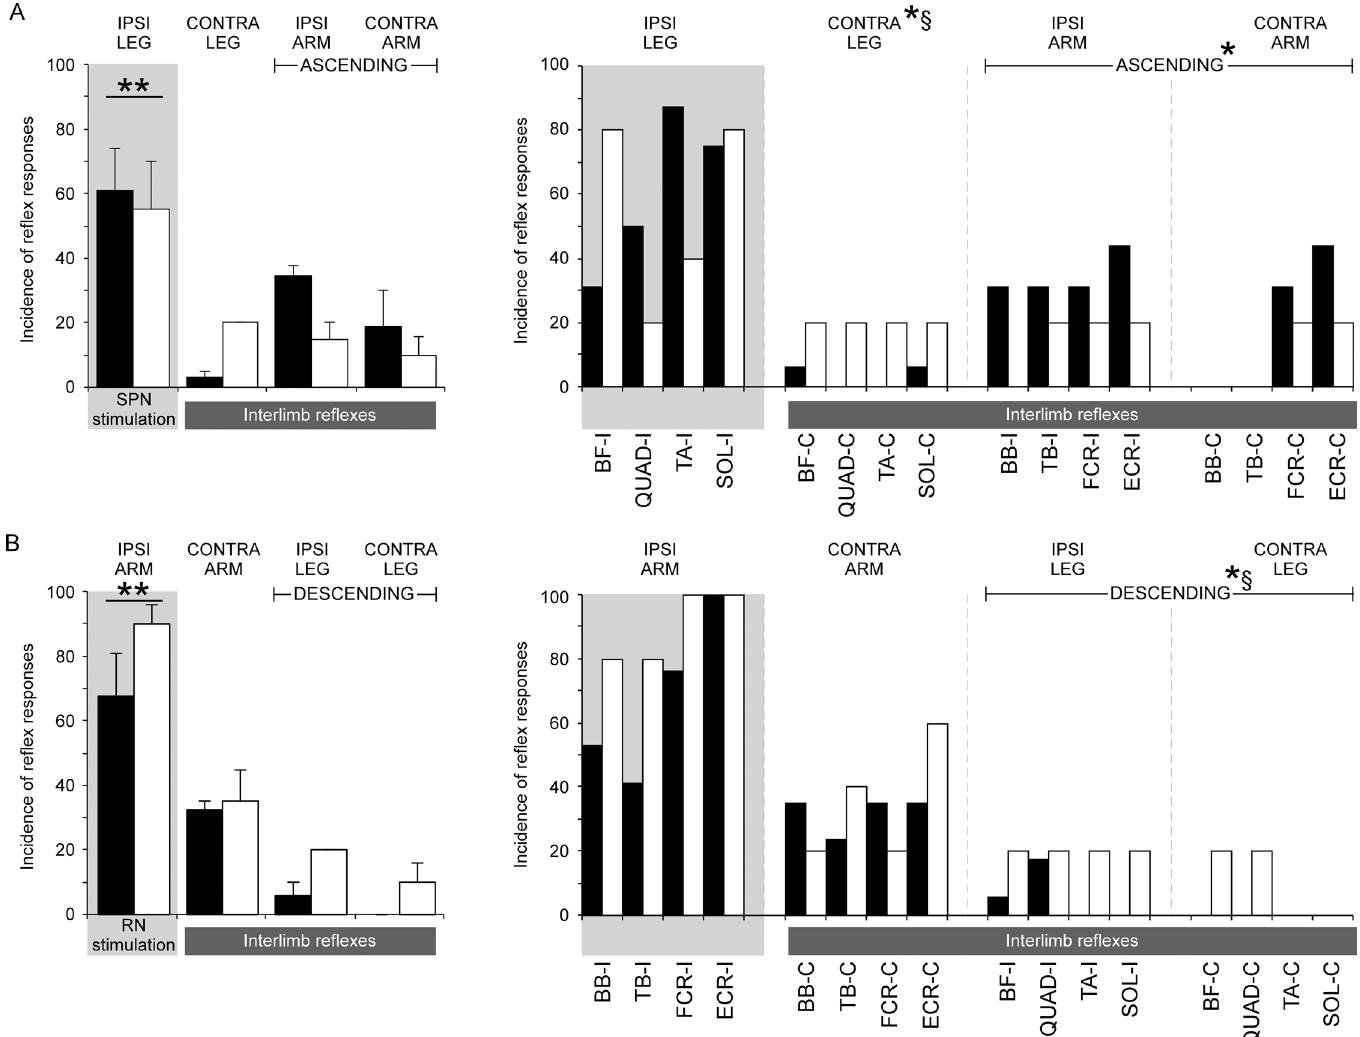
Fig 4. Incidence of within-limb, interlimb, and muscle reflexes. Incidence of limbs (left) and muscles (right) in which reflexes were evoked in participants with spinal cord injury (SCI) (filled bars; n = 17) and able-bodied (AB) control participants (open bars; n = 5) by SPN stimulation (A) and RN stimulation (B). Within-limb reflex data are shaded. Muscles from the arm are indicated by BB – biceps brachii, TB – triceps brachii, FCR – flexor carpi radialis, and ECR – extensor carpi radialis, and muscles from the leg are indicated by BF – biceps femoris, QUAD – quadriceps, TA – tibialis anterior, and SOL – soleus. ** indicates significant differences in incidence between within-limb and interlimb reflexes § indicates significant differences in incidence between SCI and AB control groups. * indicates a significant relationship between having a SCI and the outcome (assessed by logistic